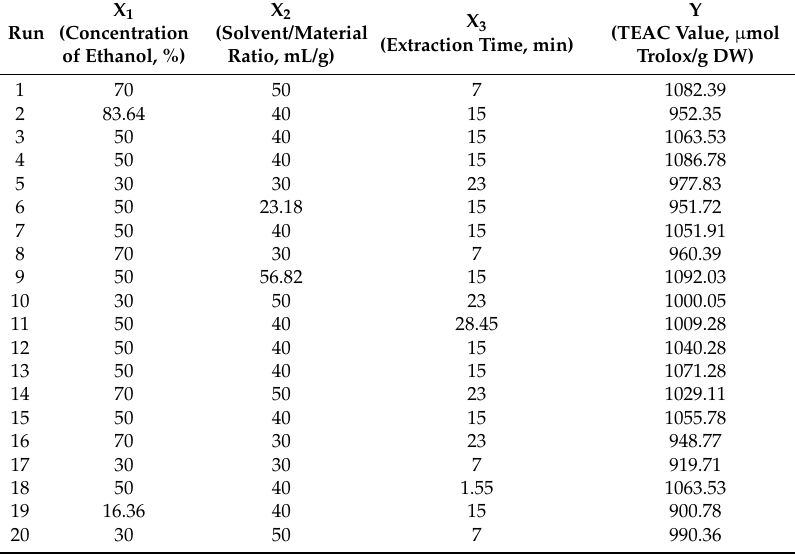
Table 1. Experimental design of response surface analysis and its experimental